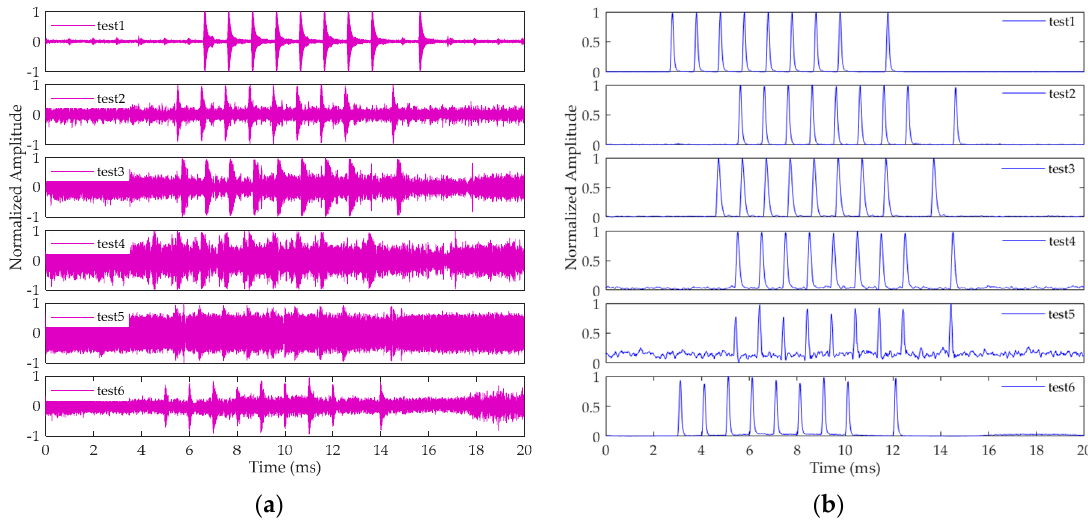
Figure 14. Actual signal and acquisition results of the method in this paper at test sites 1–6: ( a ) signal waveform; ( b ) correlation peak.